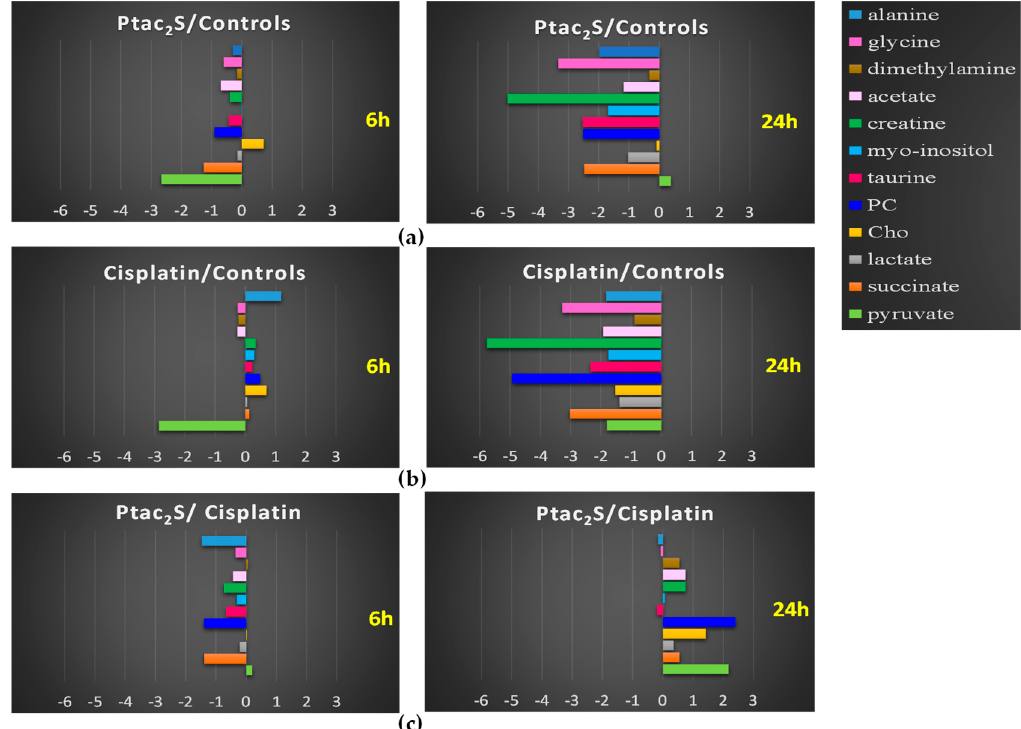
Figure 6. Relevant discriminant metabolites comparison of SKOV-3 cells aqueous extracts obtained from different pairwise groups (controls, Ptac2S, and cisplatin). The values of − Log2(FC) and the p -values are provided (Student’s t test, p -value < 0.05). ( a , b ) Metabolites with − Log2 (FC) negative values have lower concentration with respect to those of the 6 h (left panel) and 24 h (right panel) of the control, while − Log2 (FC) positive values have higher concentration with respect to those of the 6 h (left panel) and 24 h (right panel) of the control. ( c ) Metabolites with − Log2 (FC) negative values have lower concentration with respect to those of the 6 h (left panel) and 24 h (right panel) of cisplatin, while − Log2 (FC) positive values have higher concentration with respect to those of the 6 h (left panel) and 24 h (right panel) of cisplatin.